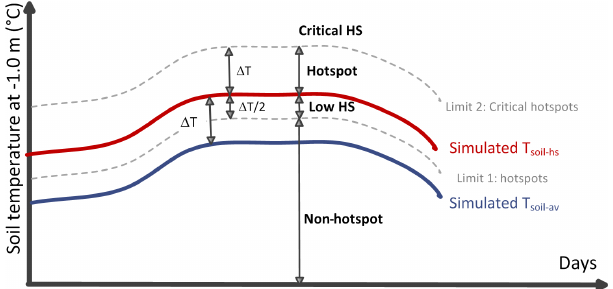
Figure 3. Schematic representation of the hotspot